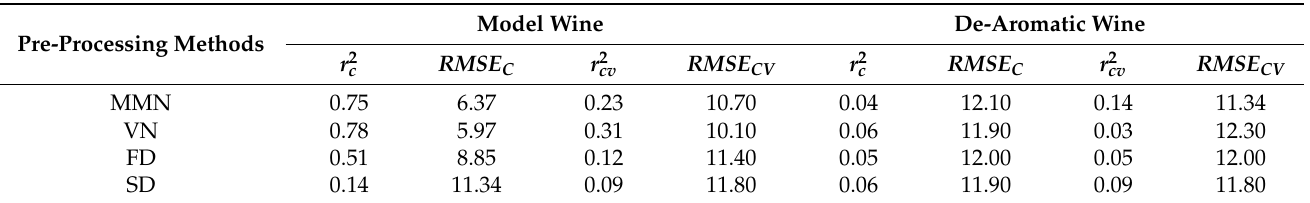
Figure 2. The spectral curves of Rose Oxide in model wine and de-aromatic wine based on ( a ) MMN; ( b ) VN; ( c ) FD; ( d ) SD. Table 1. Results of spectral full-band modeling of model wine and de-aromatic wine by four pre- processing methods (before outlier rejection).